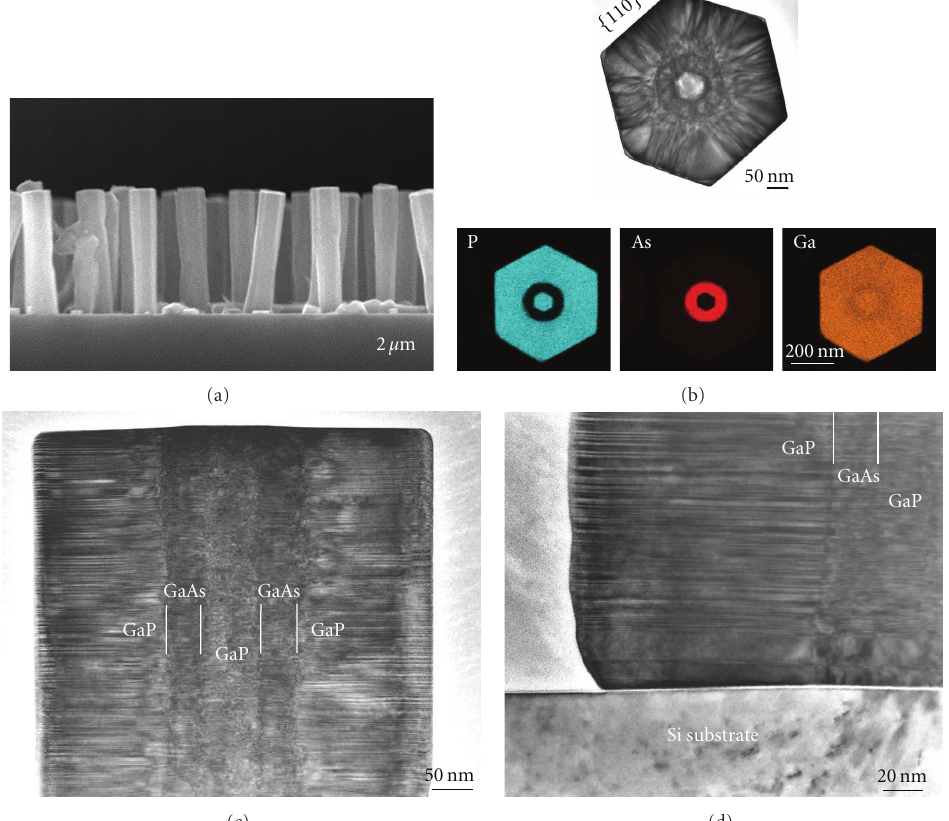
Figure 3: (a) SEM and (b)–(d) TEM images of the core-multishell GaP/GaAs/GaP nanowires. EDS mapping images are also included in (b). (a) Side view. (b)–(d) Sliced and thinned samples: (b) perpendicular to the axis; (c), and (d) along the axis.